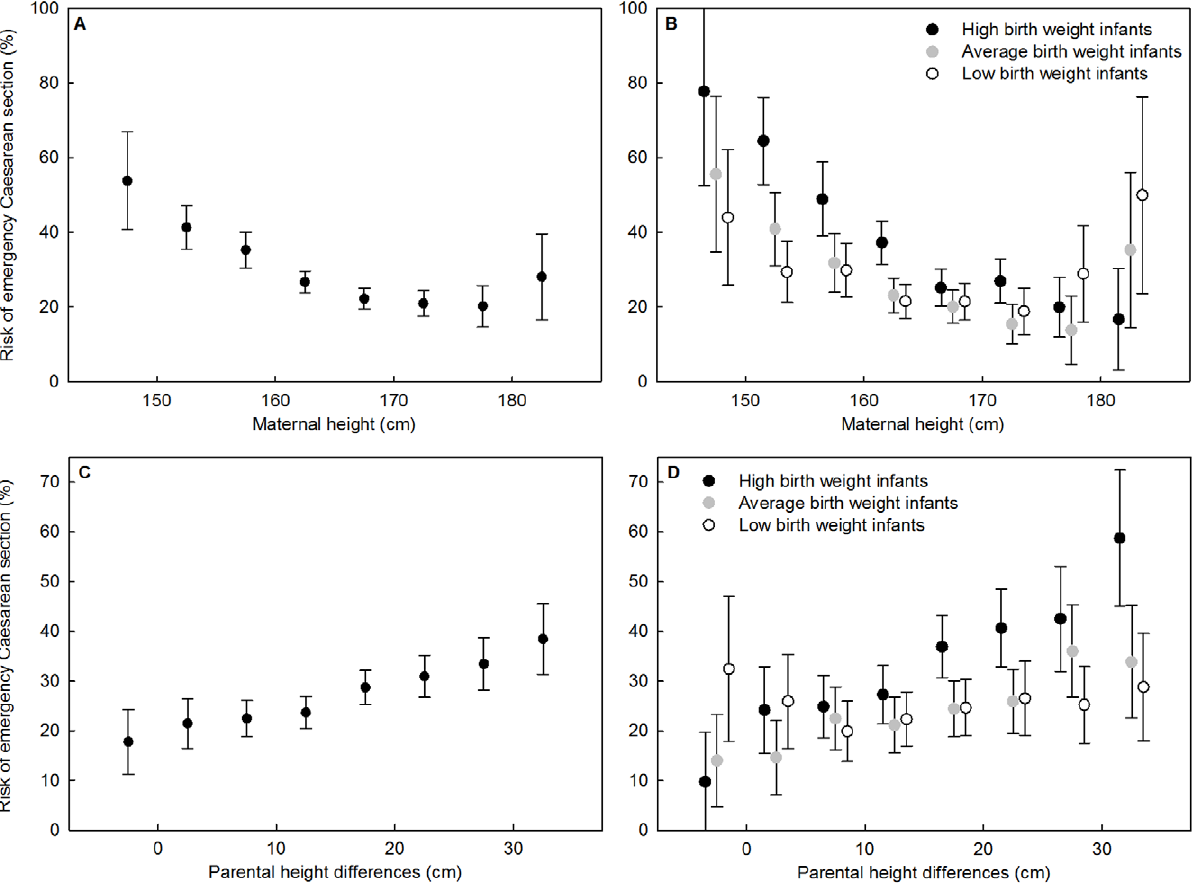
Figure 2. The effect of maternal height, parental height differences and birth weight on ECS risk. The effects (means and 95% confidence interval of raw data) are shown for (a) maternal height, (b) maternal height and birth weight (c) parental height differences and (d) parental height differences and birth weight. Height is divided into bins of 5 cm (bins lower than 145 for maternal height and 2 5 cm for parental height differences and higher than 180 and 35 cm were pooled) and birth weight was divided into tertiles. The confidence interval was determined using the Agresti-Coull method [43].